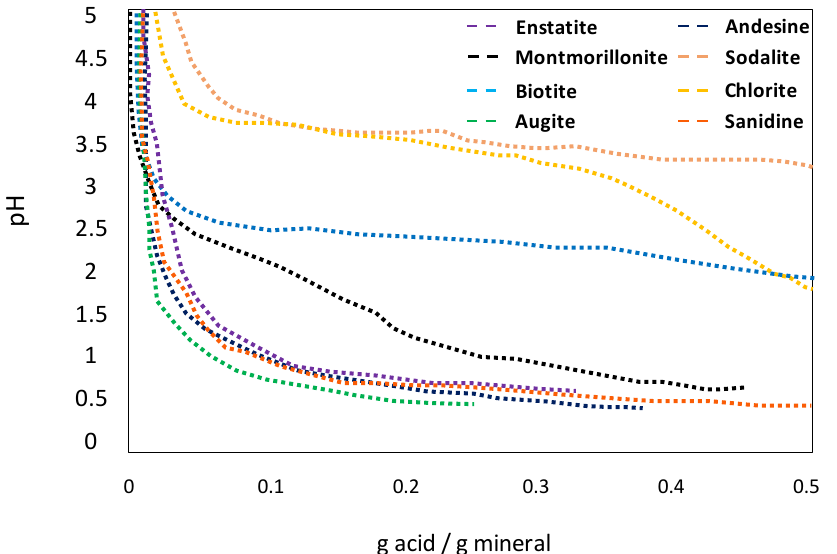
Figure 6. pH and acid consumption data for constant acid addition rate experiments (0.04 mL/min in 20 mL) with pure minerals (1 g mineral/20 mL water) Data for sodalite, chlorite, biotite, and montmorillonite represent the mean values and associated standard deviation ranges from two to four test runs for each mineral (Modified from [69]).